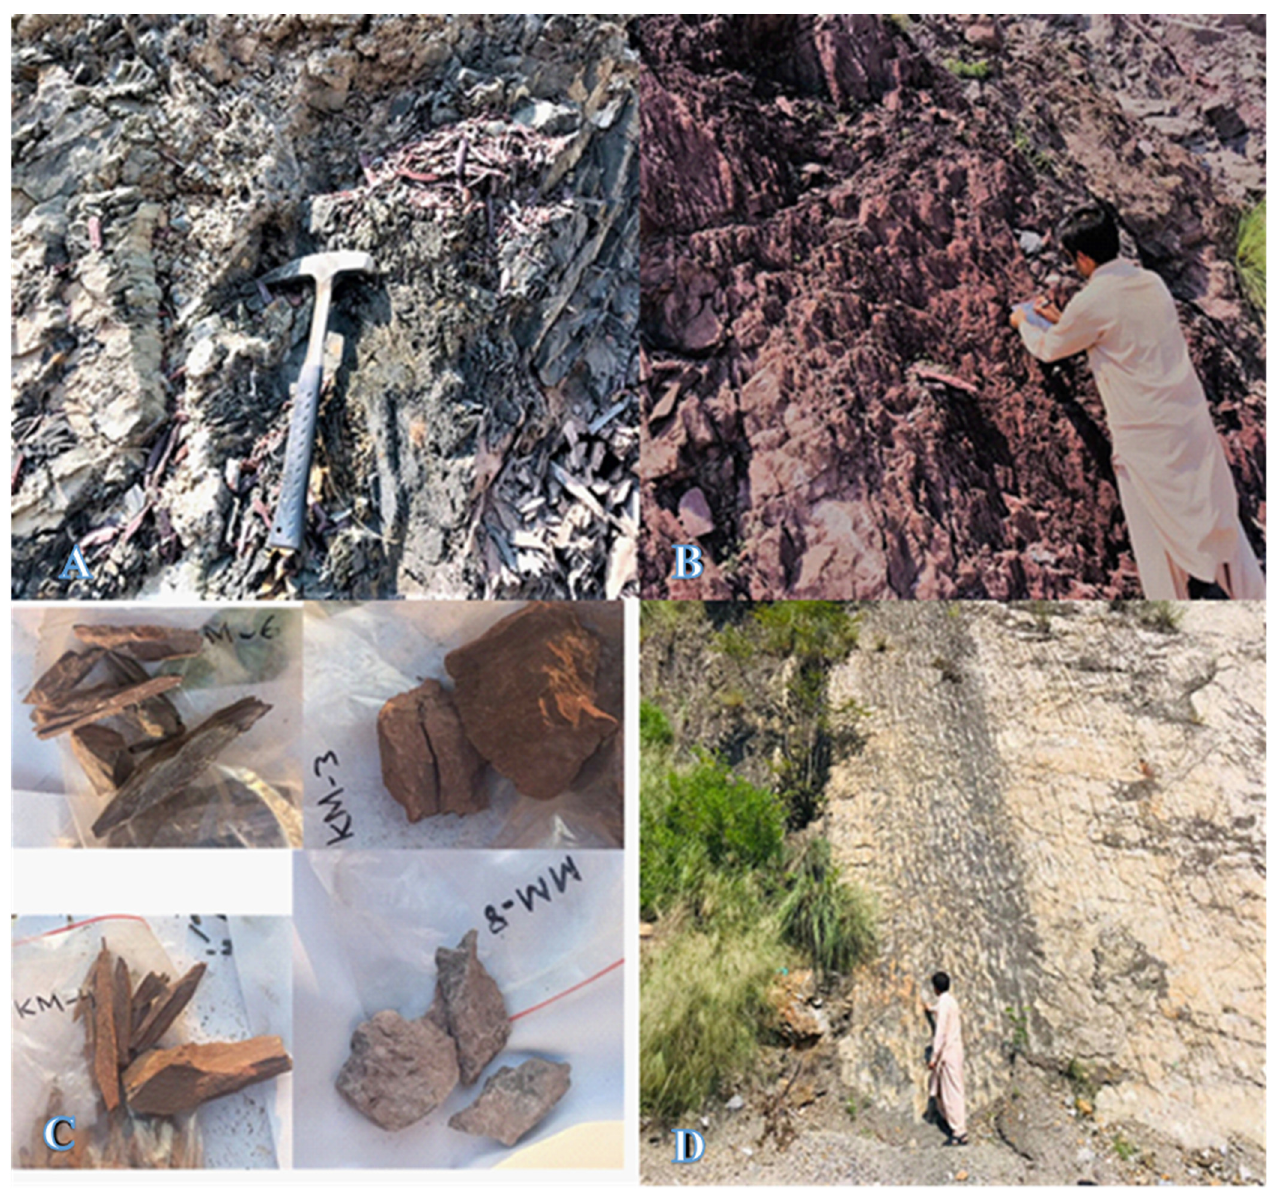
Figure 3. Field photography: ( A ) Hammer placed on the rock for cutting the rock sediments. ( B ) Sample collection from the study area. ( C ) Samples collected and placed in a polyethylene bag for palynological purposes. ( D ) View of the study area.